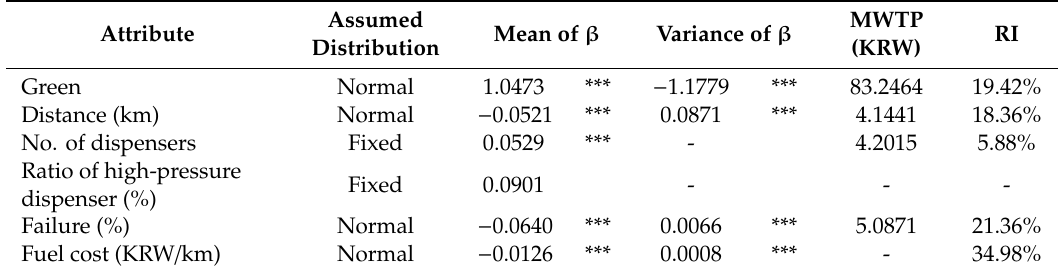
Table 3. Estimation results of mixed logit model for hydrogen refueling station (base